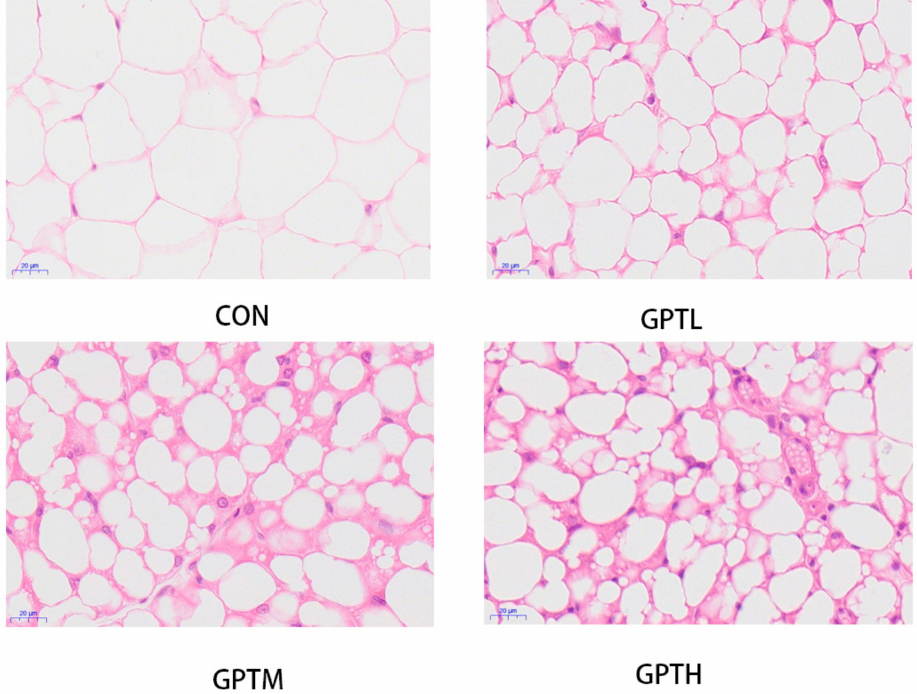
Figure 2. Hematoxylin and eosin (H&E) staining and morphology of stained abdominal adipose tissue (400 ×